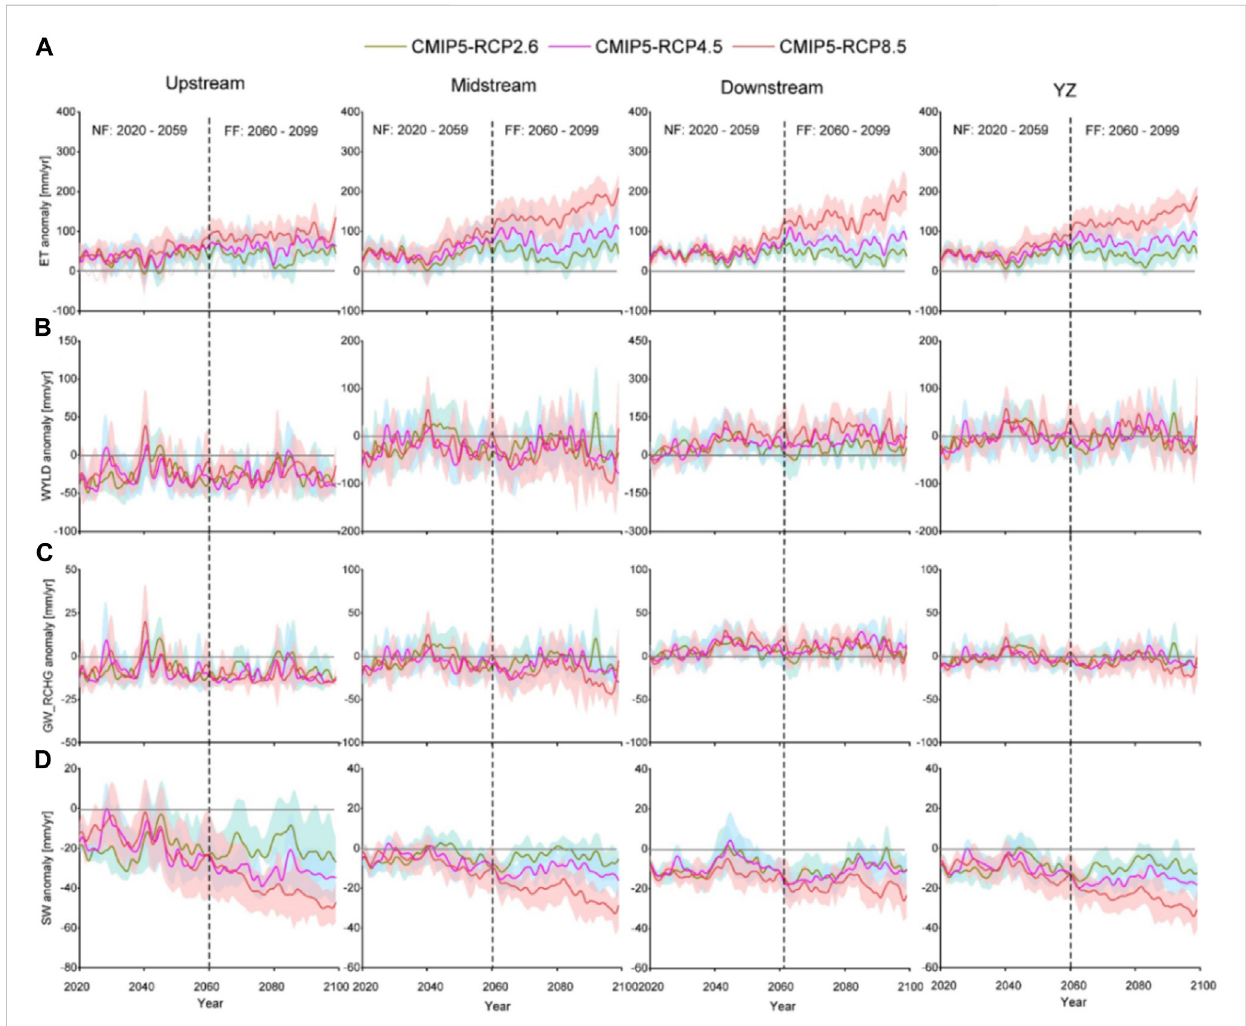
FIGURE 9 The anomalous statistics from the historical multi-year average of (A) evaporation (ET), (B) water yield (WYLD), (C) groundwater recharge (GW_ RCHG), and (D) soil water content (SW) in the upstream, midstream, downstream and YZB in the near future (NF: 2020 – 2059) and far future (FF: 2060 – 2099), under three different scenarios of CMIP5 (RCP2.6, RCP4.5,